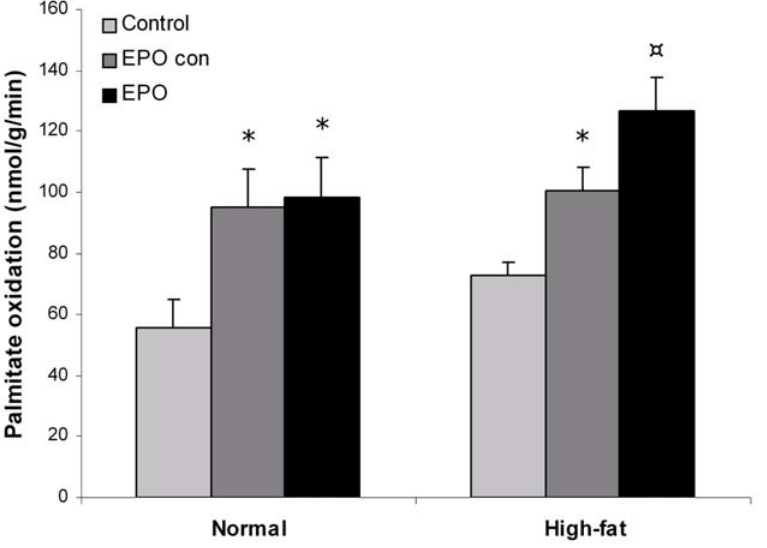
Figure 6. EPO over-expression increases exogenous palmitate oxidation. One week after EPO electrotransfer C-14 palmitate oxidation was measured in muscle homogenates from transfected muscle, the contralateral tibialis cranialis muscle of the same mouse and control muscle from non-transfected animals. Statistical significance was tested by Student’s t-test with Bonferroni corrections for multiple testing. * indicates significance at p , 0.05, while ¤ indicates significance at p , 0.01.